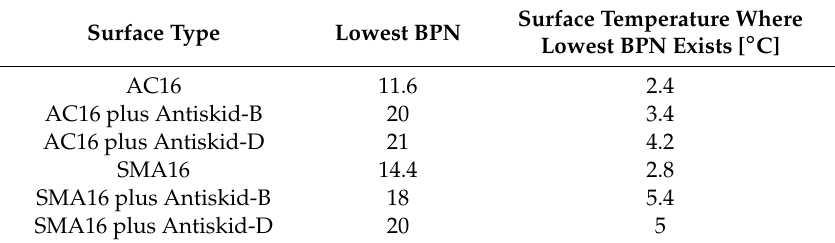
Figure 7. Relationship between surface temperature and BPN value. Table 5. Lowest temperature and lowest BPN